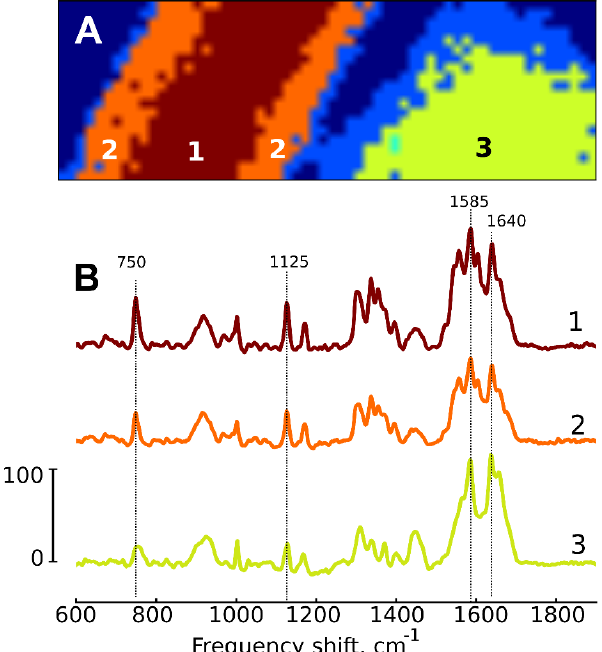
Figure 9. ( A ) Cluster maps of rod-shaped (range and brown colors) and round-shaped (yellow) cardiomyocytes. Each color corresponds to the individual cluster consisting of pixels that were defined to have similar Raman spectra. ( B ) Averaged Raman spectra for each cluster. Spectrum color and number correspond to the color and number of its cluster in panel A. For clearer representation spectra are vertically shifted. Peaks with the maximum positions at 750 and 1125 cm −1 correspond to heme vibrations in c -and b -type cytochromes of mitochondria; peaks at 1585 and 1640 cm −1 correspond to heme vibrations in oxymyoglobin in cardiomyocyte cytoplasm. Reprinted from [90] with permission by Creative Commons